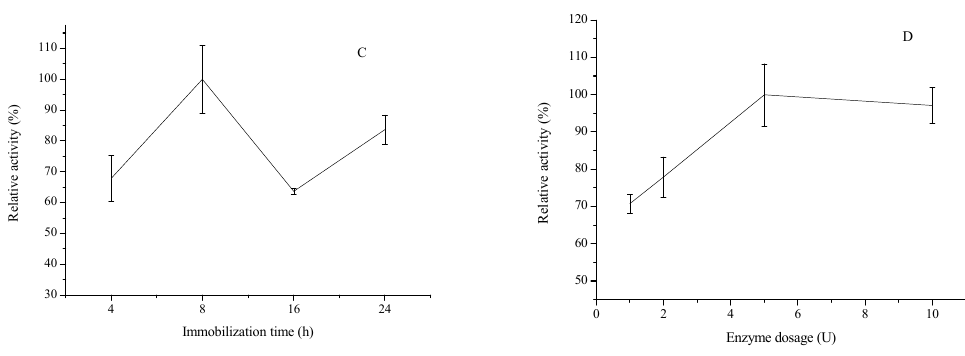
Figure 2. Effect of immobilization pH ( A ); reaction temperature ( B ); immobilization time ( C ) and enzyme dosage ( D ) on the relative activity of the immobilized COX-2 ( n = 3). The effects of reaction time on the relative activity of the immobilized COX-2 were also studied.